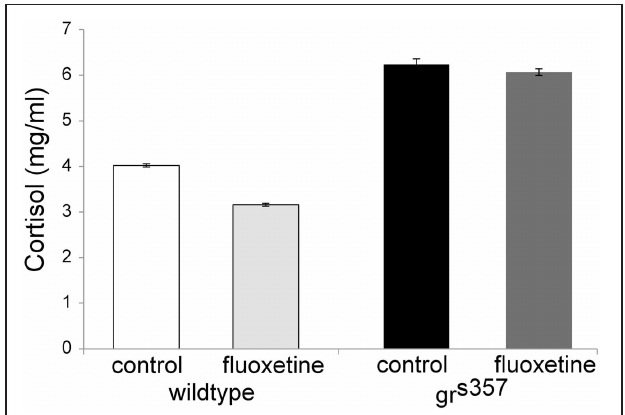
FIGURE 3 | Whole body cortisol measurements in 7 day old zebrafish larvae. Cortisol measurements in 7 day old gr s357 mutants and wildtype siblings with and without fluoxetine treatment. Each group consisted of 24 larvae processed together, split into two duplicate samples, and tested concurrently. Values shown are transformed from ELISA absorbance measurements. Error bars are SEMs of the two duplicate samples per